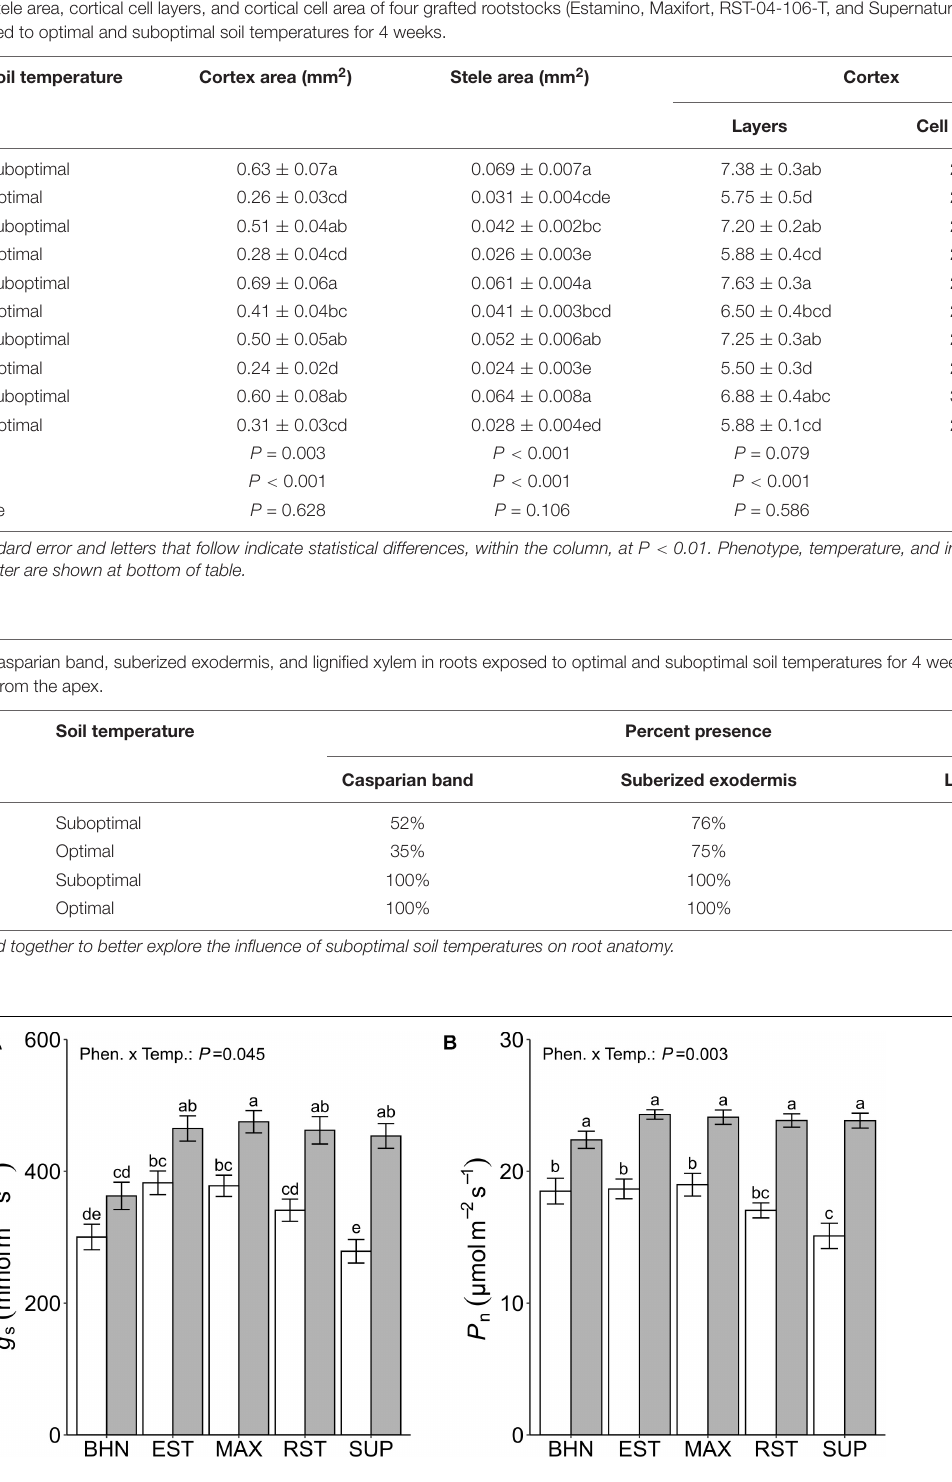
Frontiers in Plant Science |